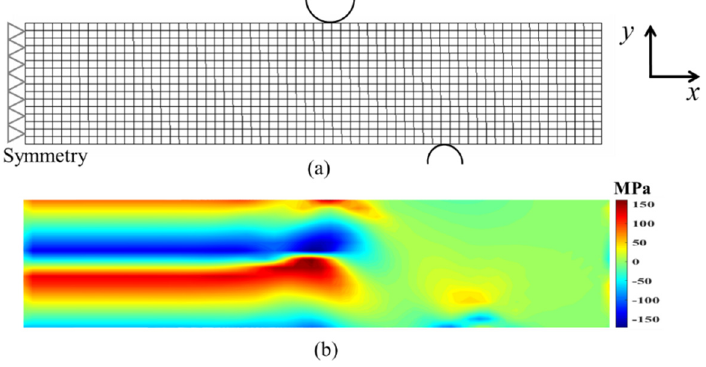
Figure 3. Fourpoint bending model and simulated residual stress field: ( a ) four-point bending model; ( b ) simulated residual stress field ( σ x